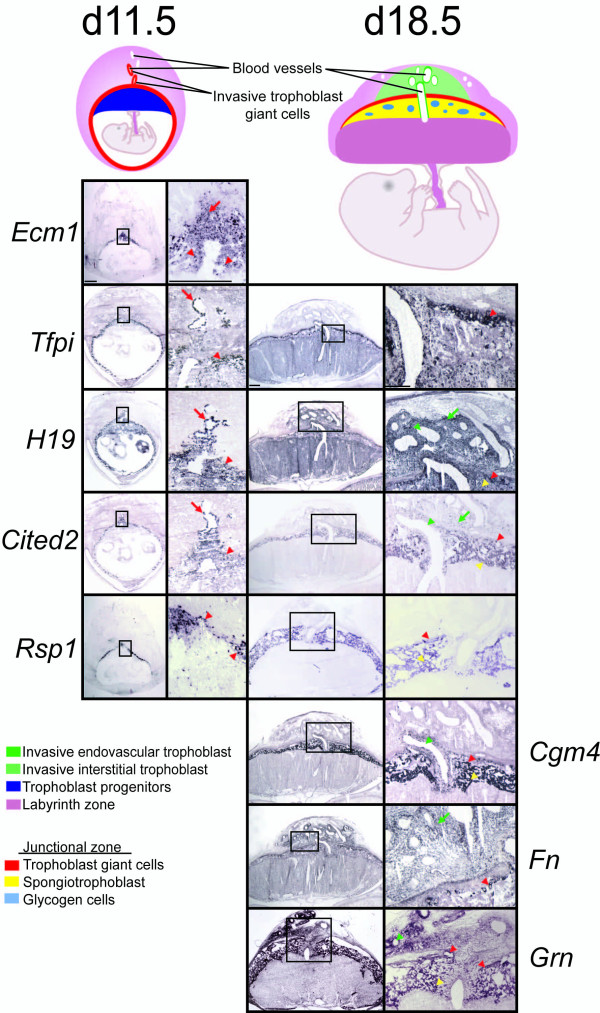
'Differentiation-associated' genes are expressed by trophoblast cells developing within the chorioallantoic placenta. In situ detection of mRNA expression of 'differentiation-associated' genes in gestational d11.5 and d18.5 rat placentation sites is presented. Bars = 1 mm. Left panels, d11.5 placentation sites, far left: low magnification; middle left: high magnification of boxed area. Right panels, d18.5 placentation sites, middle right: low magnification; far right: high magnification of boxed area. Red arrowheads, trophoblast giant cells; red arrows, invasive trophoblast giant cells; yellow arrows, spongiotrophoblast; green arrowheads, endovascular invasive trophoblast; green arrows, interstitial invasive trophoblast.